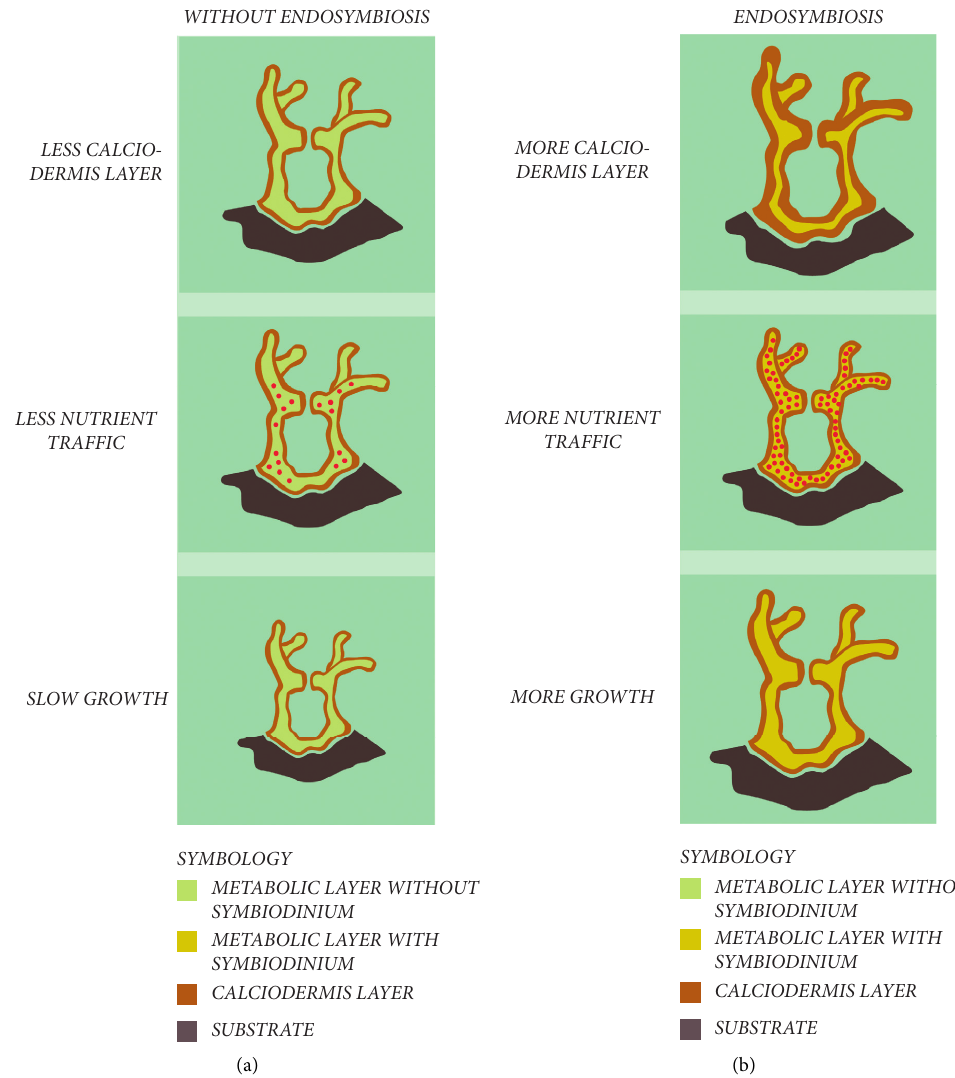
Figure 4: Organismal system processes, showing in a comparative scenario how different processes as calcidodermis production, nutrient traffic, and coral growth are enhanced by the endosymbiosis interaction (b) with respect to the coral without Symbiodinium